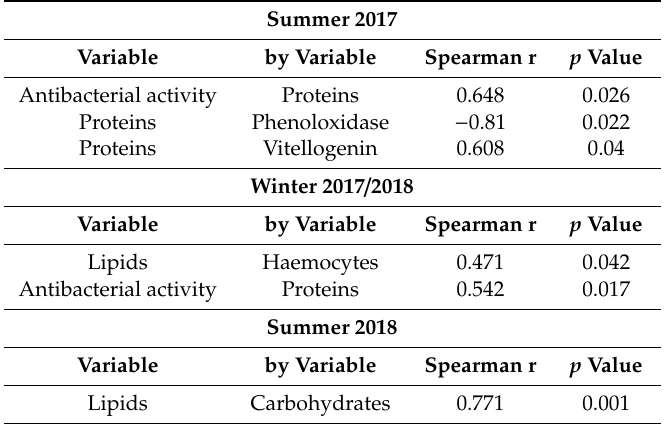
Table 1. Spearman rank correlations for the different variables which showed significant p -values for the three seasons, summer 2017, winter 2017/2018, and summer 2018.